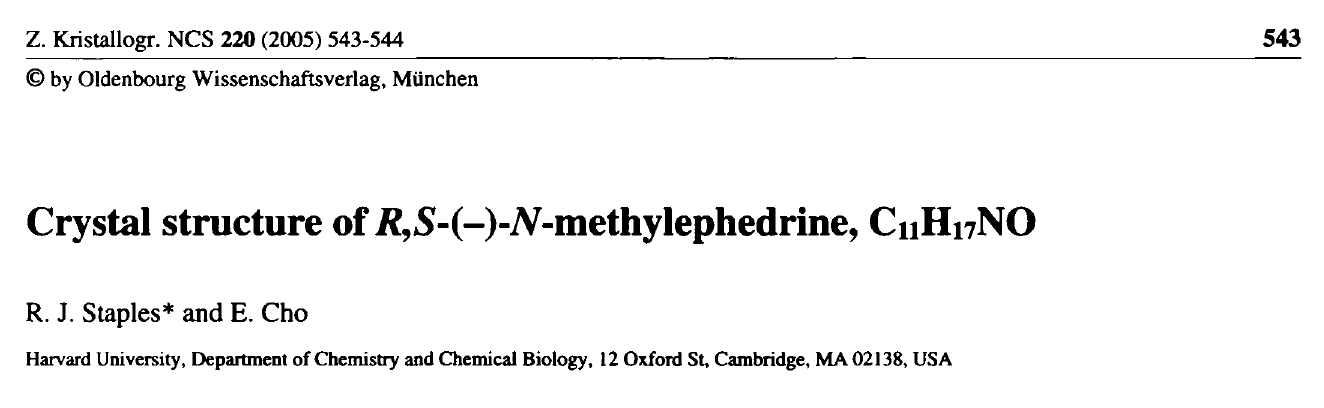
Table 1. Data collection and handling. Crystal: Wavelength: